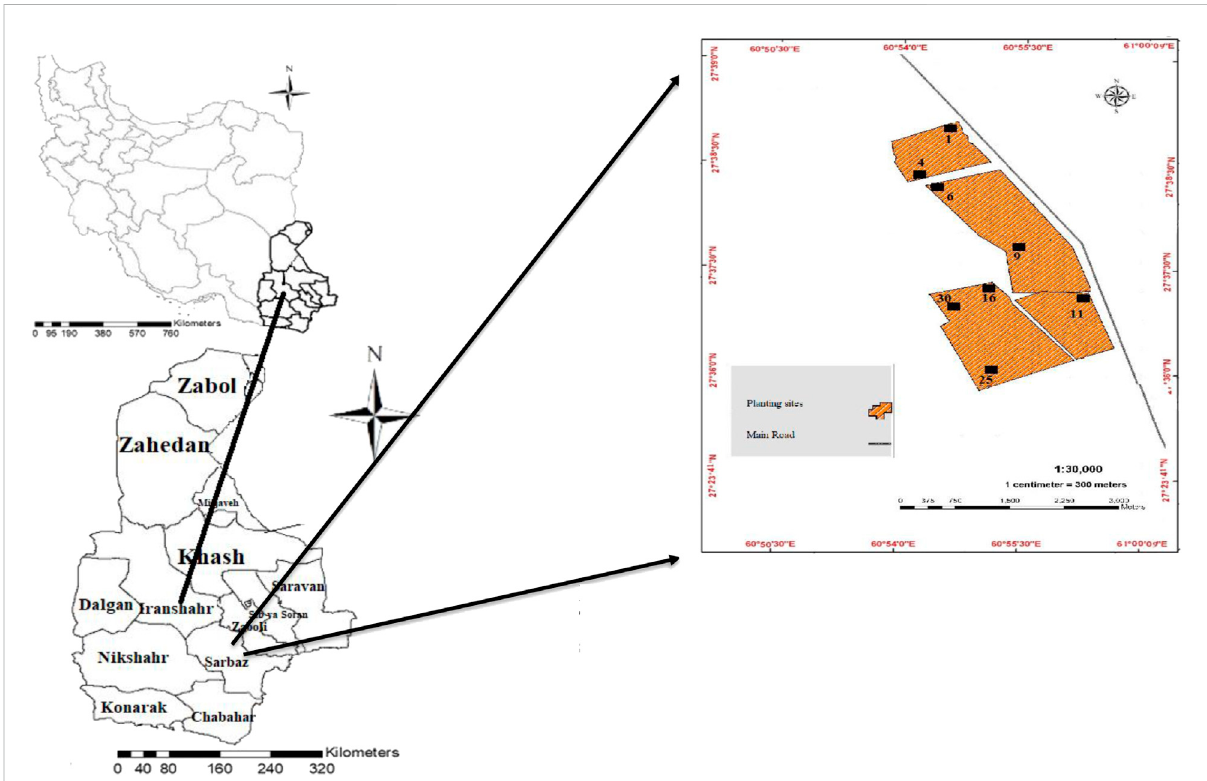
FIGURE 1 Sampling sites in the Shams Abad arti fi cial forest, Iran. The black squares indicate the sampling sites, and the numbers below the squares indicate the ages of the